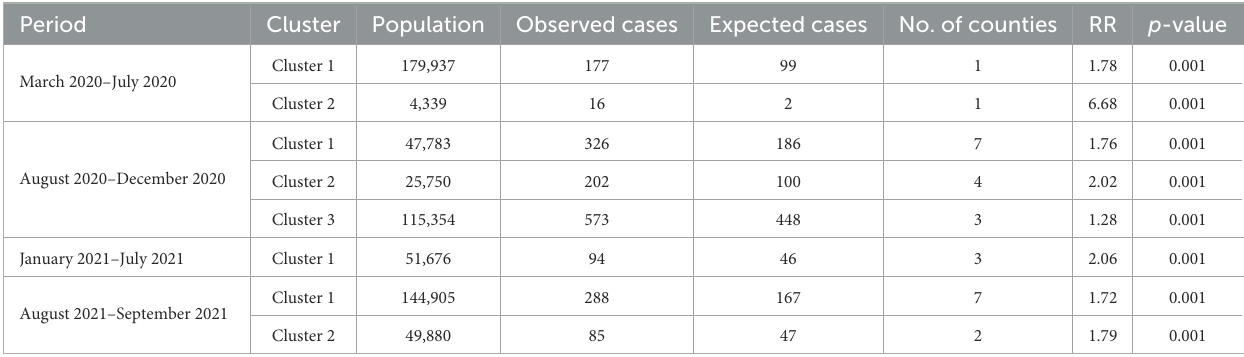
TABLE 1 Spatial clusters of age-adjusted high COVID-19 hospitalization risks identified in North Dakota using Tango’s flexible spatial scan statistics, March 2020–September 2021. Period Cluster Population Observed cases Expected cases No. of counties RR